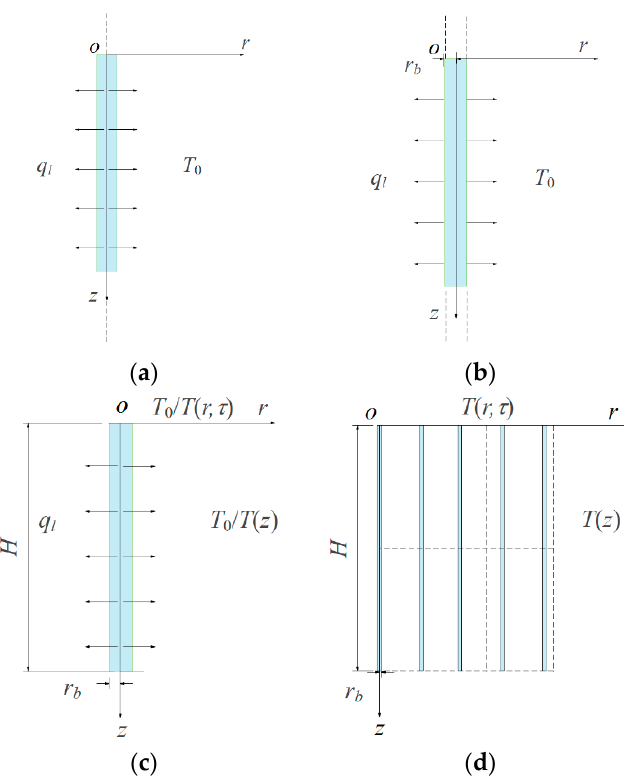
Figure 2. Schematic representation of ( a ) ILS; ( b ) ICS; ( c ) FLS, including FLSN, FLSA, and FLSCC; ( d ) DST.